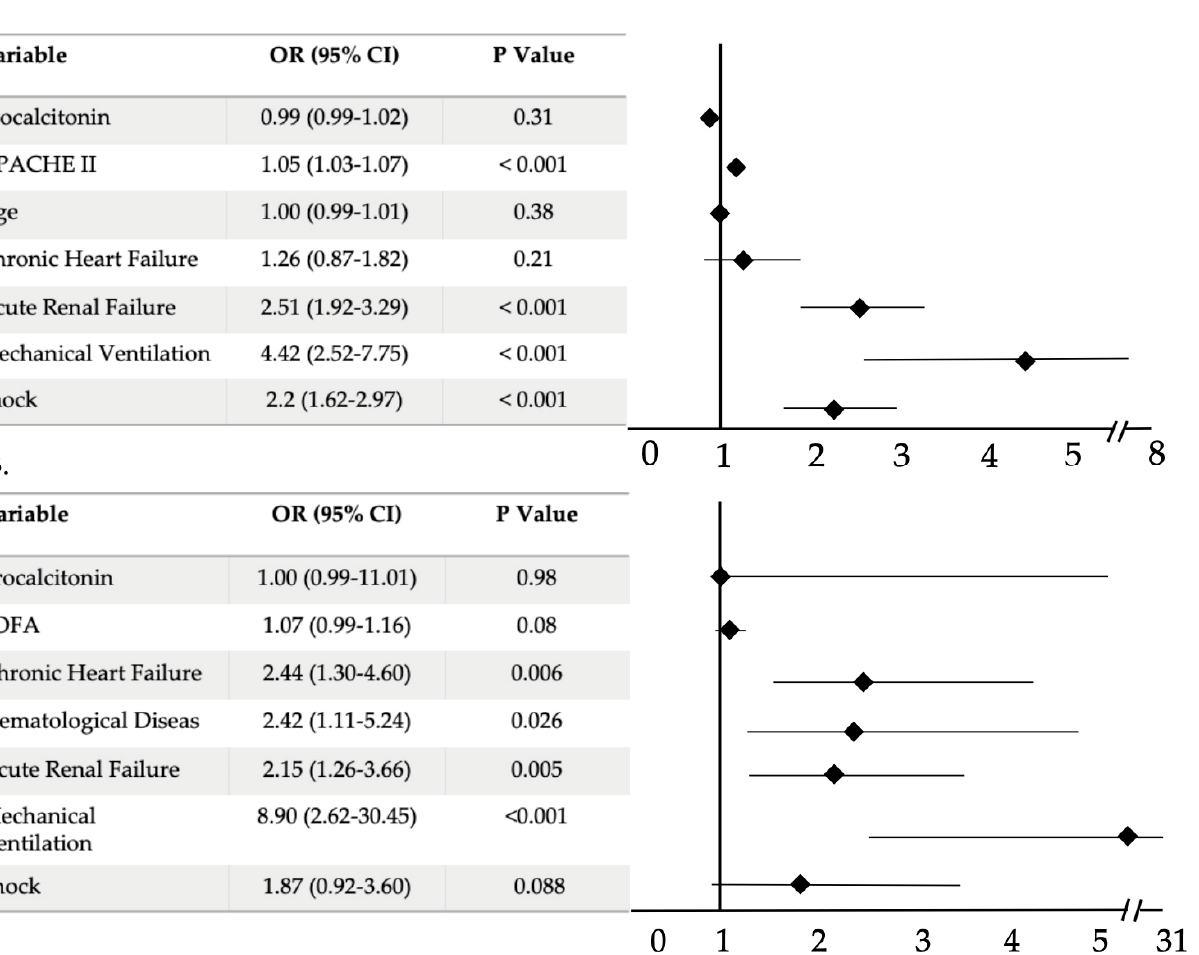
Figure 3. Multivariable analysis of factors associated with ICU mortality in overall population ( A ) and in bacterial co- infection group ( B ). Abbreviations: APACHE, Acute Physiology and Chronic Health Evaluation; SOFA, sequential organ failure assessment; CI, confidence interval.